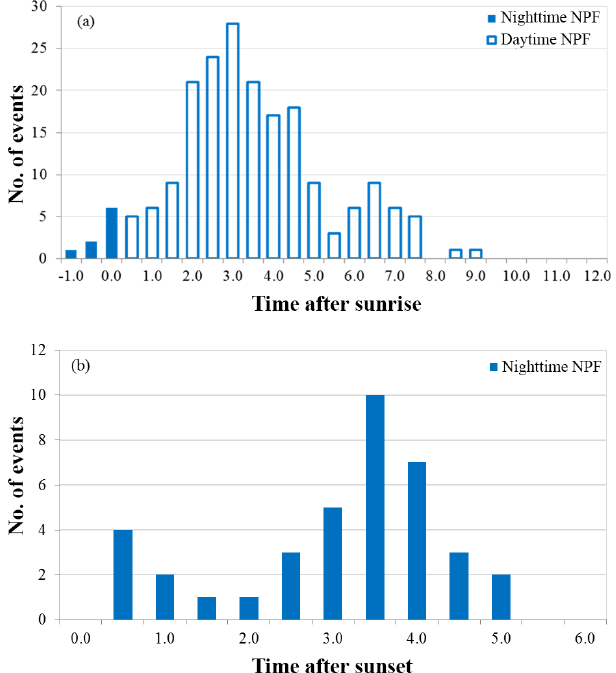
Figure 1. Distribution of start times of day time NPF events as a function of time after sunrise (a) night time NPF events as a function of time after sunset (b) . In panel (a) the three bars on the extreme left correspond to times before